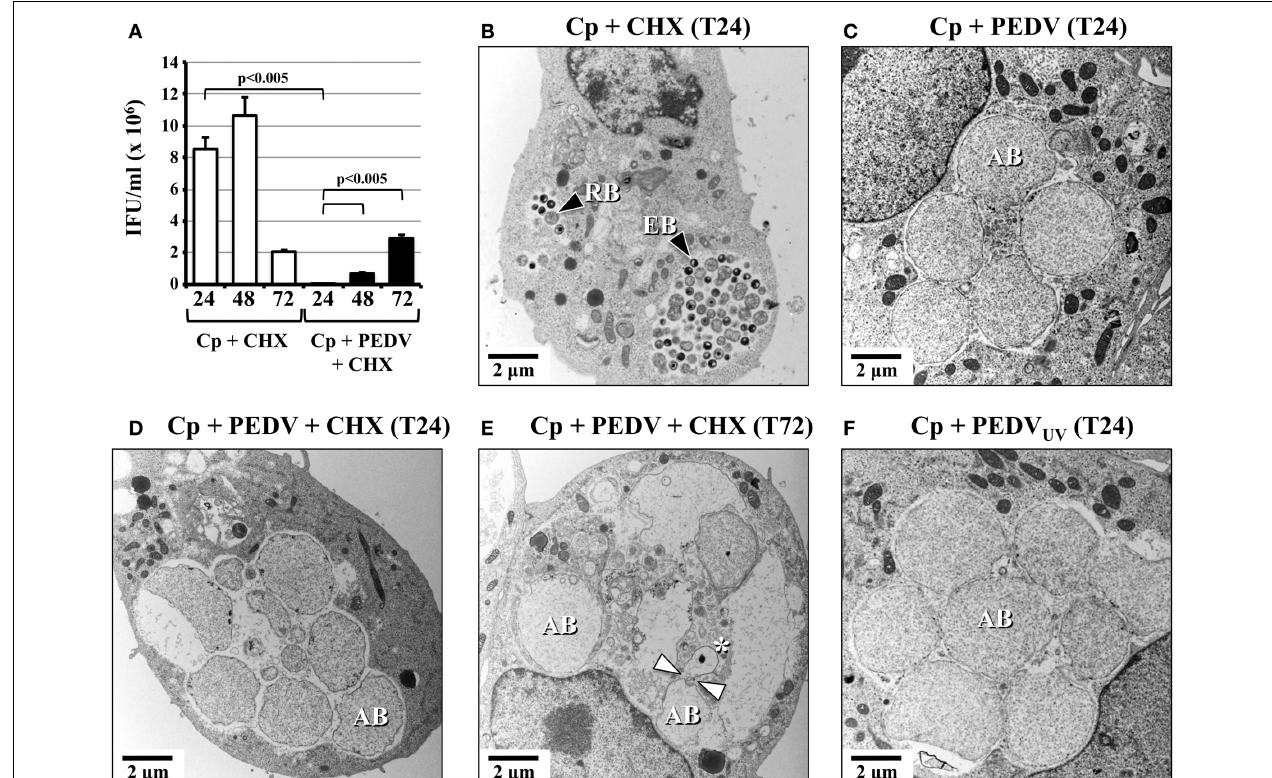
FIGURE 4 | The PEDV-induced developmental cycle disruption is reversible. (A) Vero cells were mock-infected (Mock; data not shown), mono-infected with C. pecorum (Cp), or co-infected with C. pecorum and PEDV (Cp + PEDV) as diagrammed in Figure 1A . Cultures ( + CHX) were pre-exposed to 5 μ g/ml CHX starting at 1h before viral infection to prevent PEDV replication, as described in Figure 1A . At 24 hpvi (T24), 48 hpvi (T48), and 72 hpvi (T72), replicate coverslips were used for sub-passage titer analysis. Inclusion counts were used to calculate inclusion forming units (IFU)/mL (Y-axis). The time hpvi and sample are shown below the X-axis. The average from three biologic replicates ± s.e.m. is shown; these data are representative of three independent experiments. Statistical comparisons are